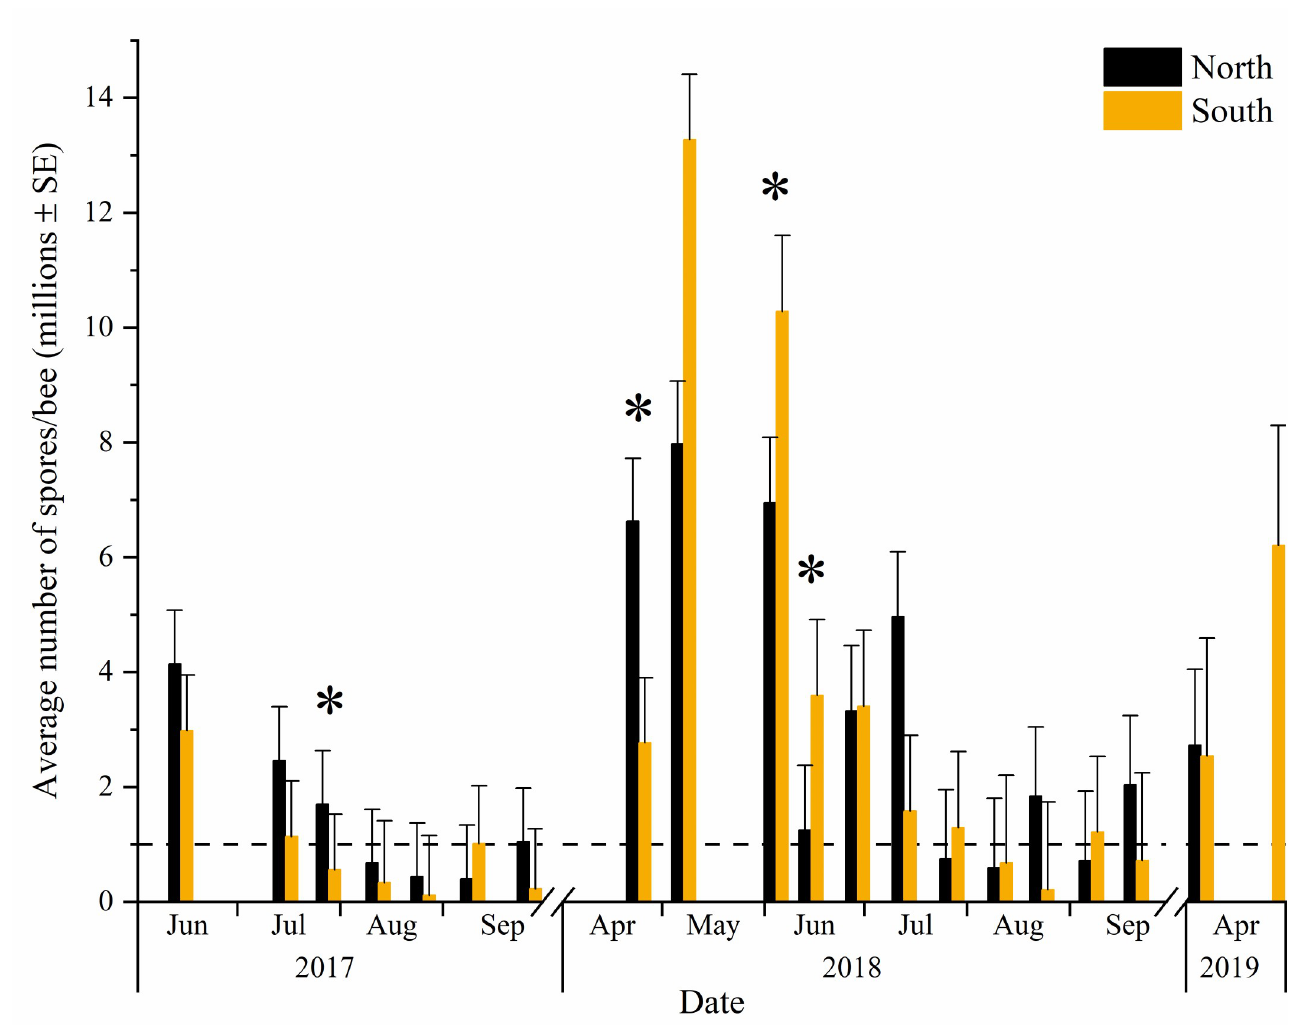
Fig 2. Influence of geographic location on average Nosema abundance over 23 months. North represents colonies near Edmonton and South represents colonies near Rainier. Data are plotted as untransformed means. Dashed line shows the 1 million spores/bee nominal threshold. Asterisks indicate significant differences (P < 0.05, Slice) between locations within